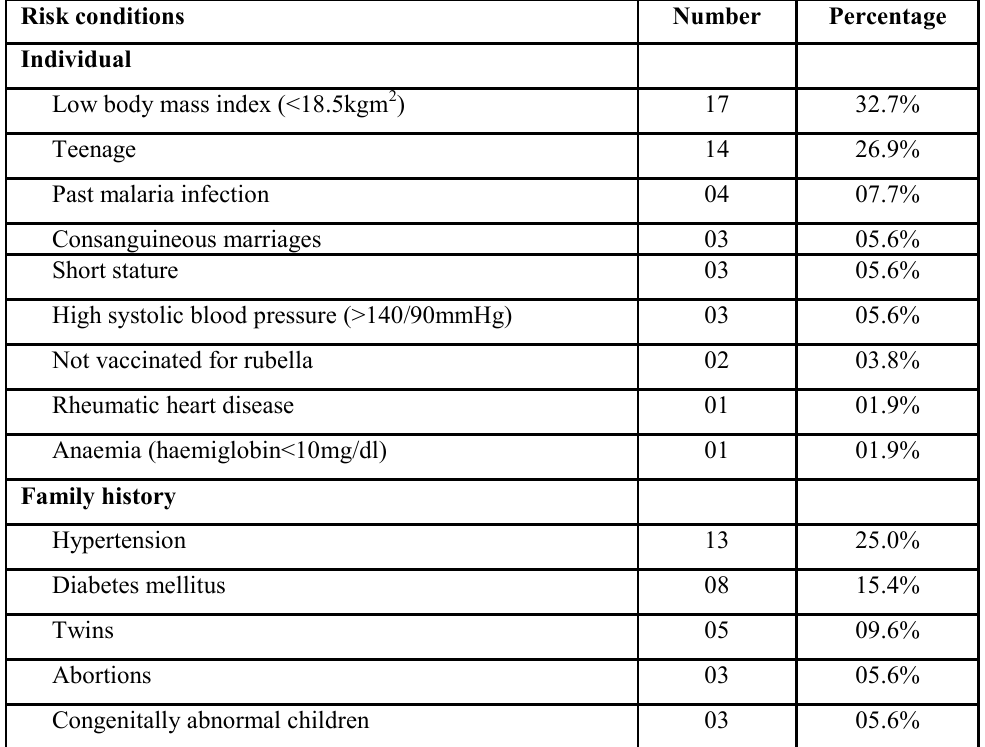
Table 03: The risk conditions identified in the female